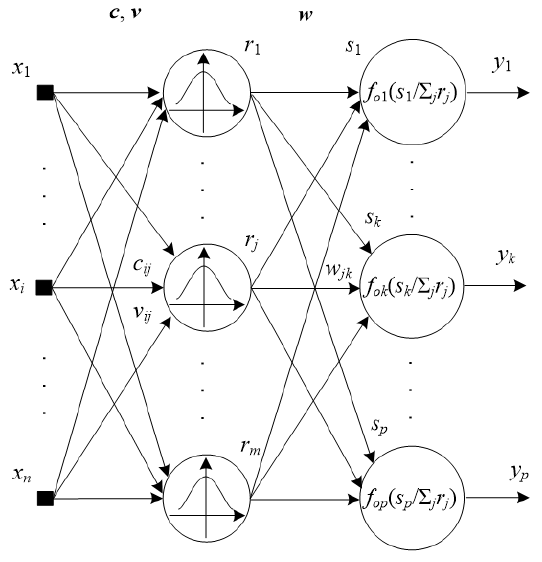
Figure 2. Fuzzy neural network with a single hidden layer.